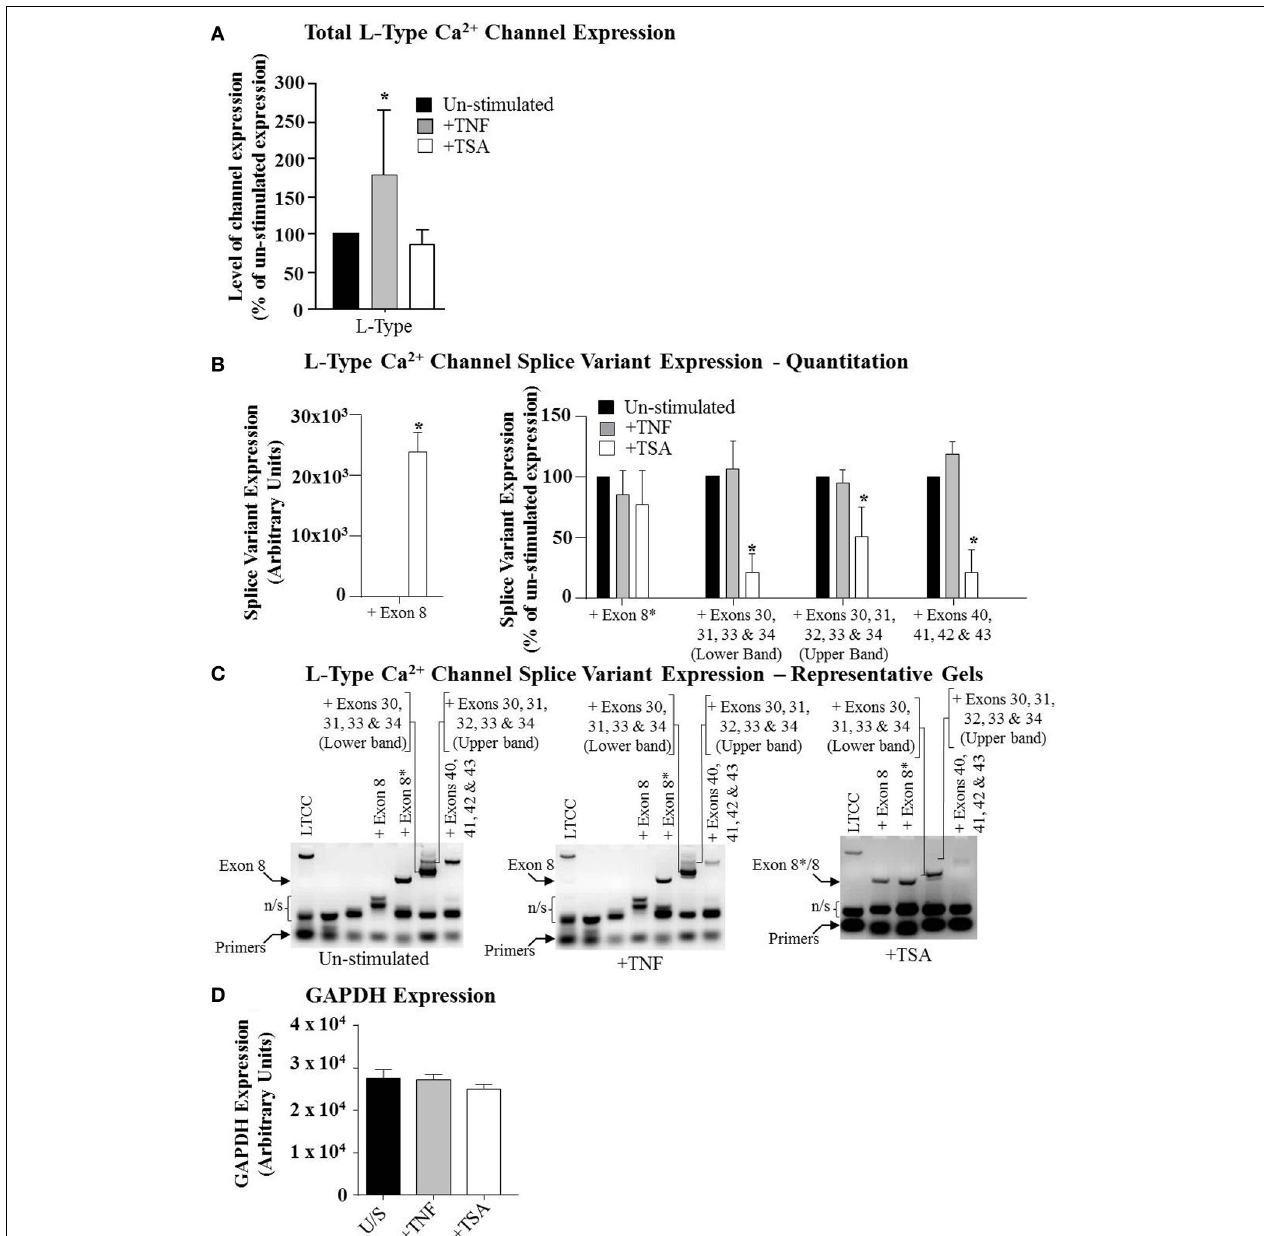
FIGURE 4 | The expression of the L-Type Ca 2 + channel and splice variants in primary myometrial cell cultures. Primary myometrial cell cultures were stimulated with 10ng/ml TNF, 100ng/ml TSA or left unstimulated. RNA was extracted, reverse transcribed and amplified using channel and splice variant specific primers. Manual quantification of the relative band intensities were used to quantify the level of expression and this was expressed as a percentage of the un-stimulated expression. (A) TNF significantly increased